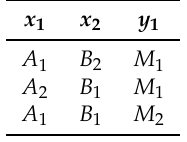
Table 1. Knowledge base example for Equation (16).